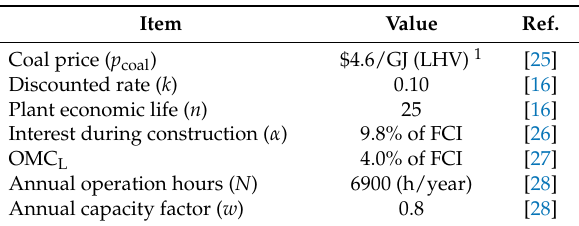
Table 4. Major assumptions for COE